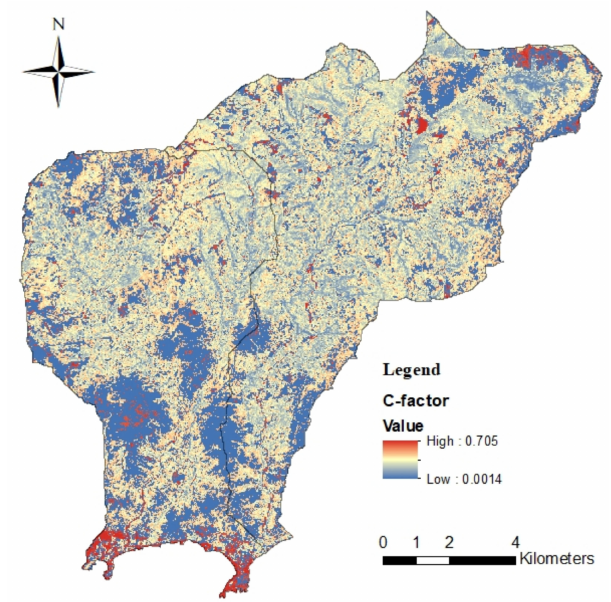
Figure 12. C(r)-factor